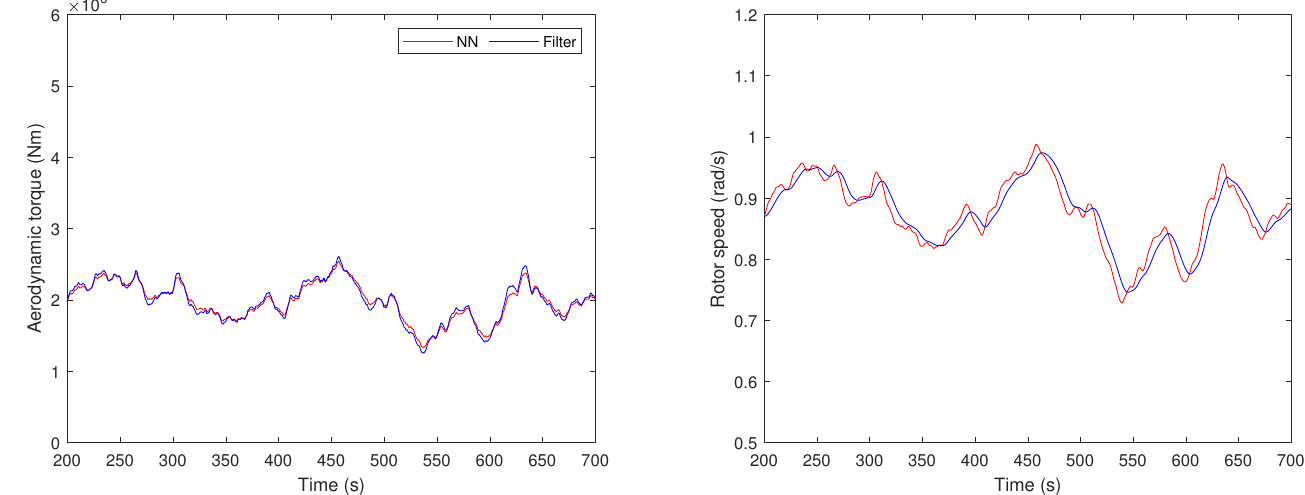
Figure 17. Output at a mean wind speed of 8 m/s (mode 2).